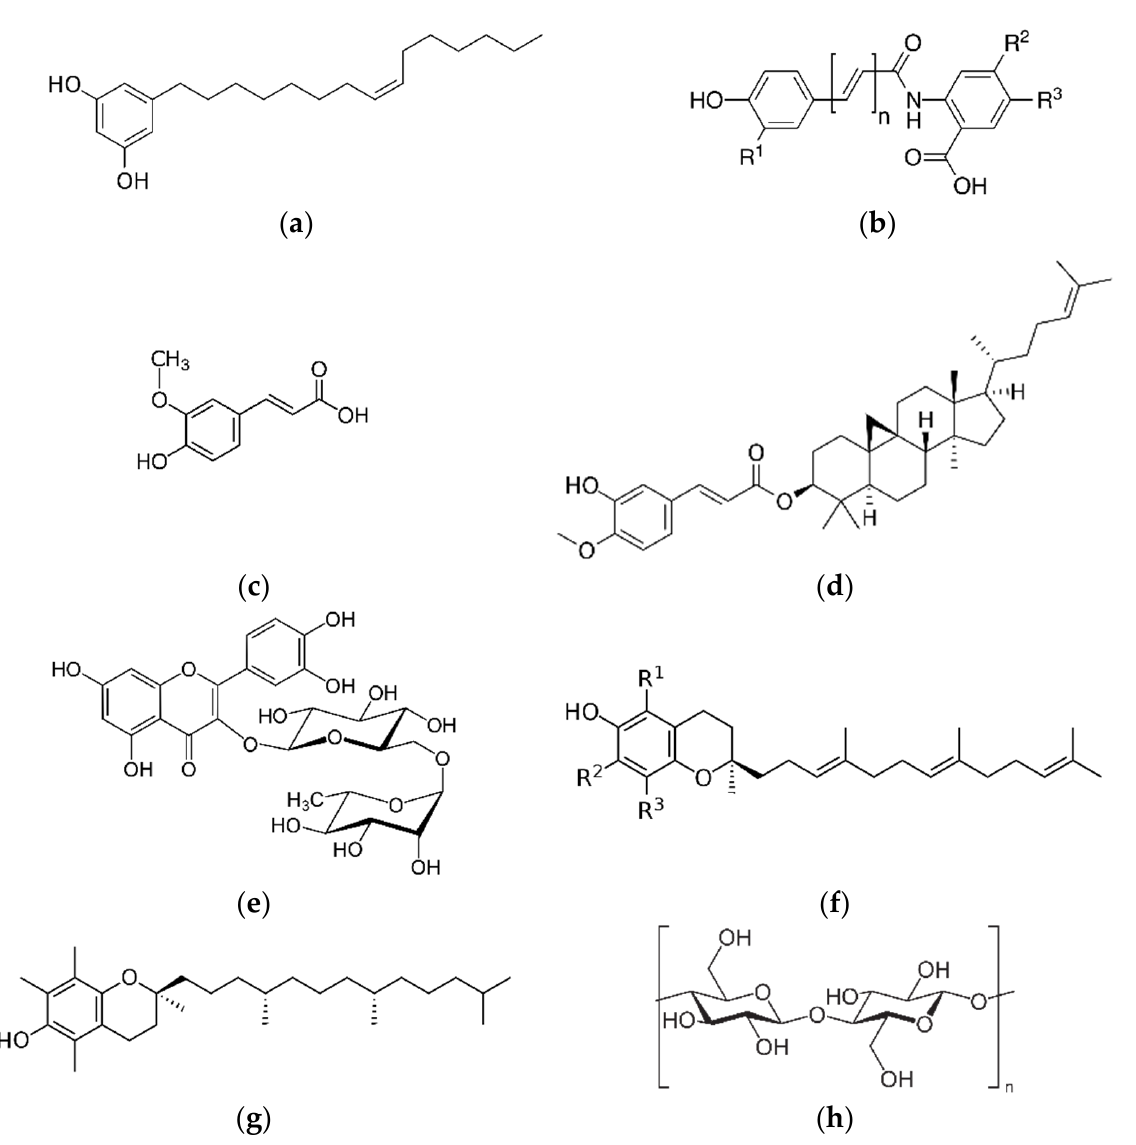
Figure 2. Main structure of whole grain-derived bioactive compounds ( a ) alkylresorcinol, ( b ) avenanthramide, ( c ) ferulic acid, ( d ) γ-oryzanol, ( e ) rutin, ( f ) tocotrienol, ( g ) α-tocopherol, and ( h ) β-glucan.